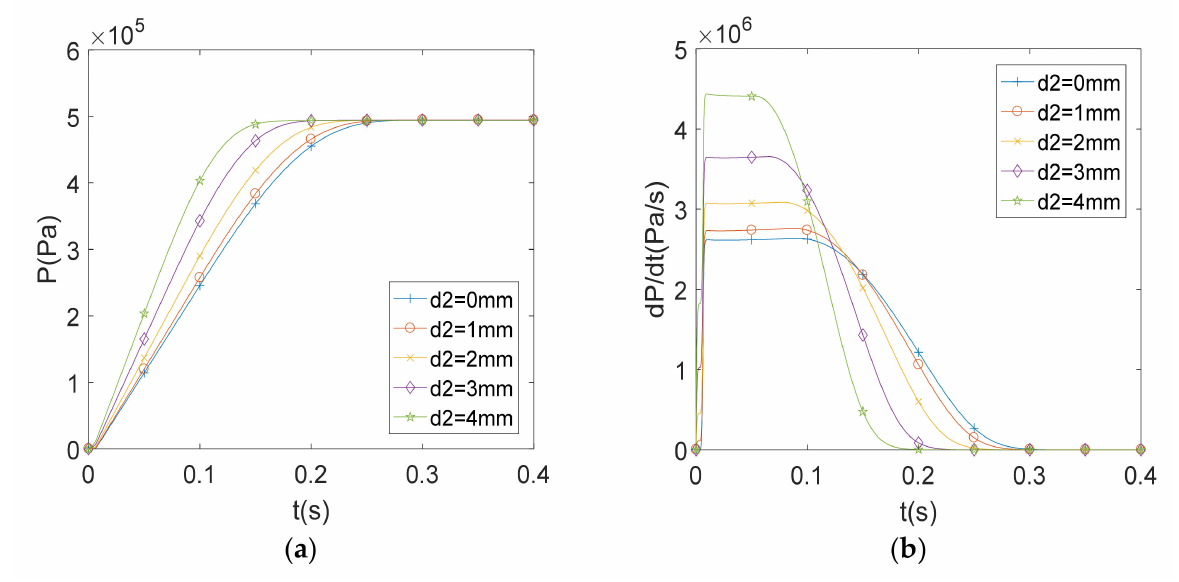
Figure 11. Influence of the opening diameter of the check valve on pressure change rate: ( a ) pressure response; ( b ) pressure change rate response.